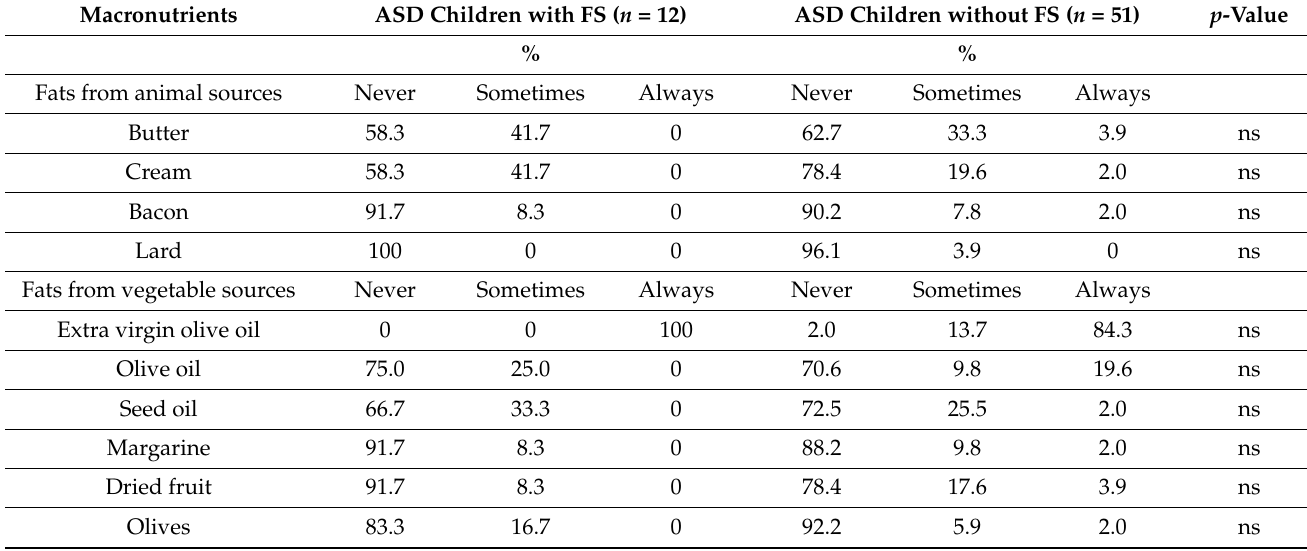
Table 7. Comparison of the rates of annual intake of animal and vegetable fats in each group between ASD children with and without